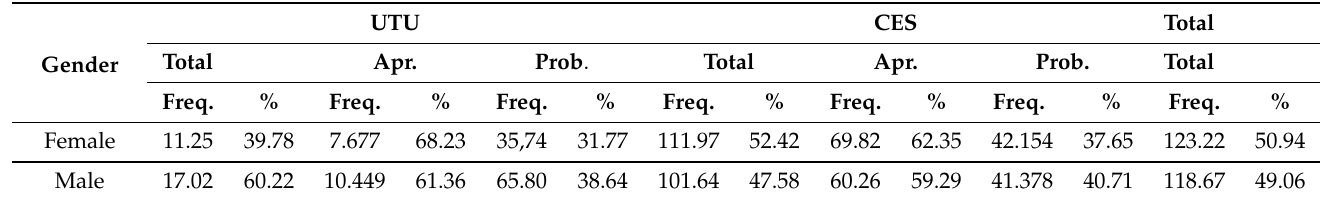
Table 1. Number and percentage of students per database and final situations according to gender.